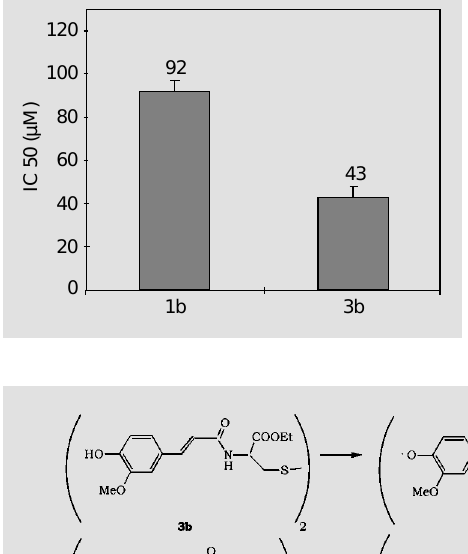
Figure 3 - Concentration of disul- fides 1b and 3b for 50% of cyto- chrome c reduction